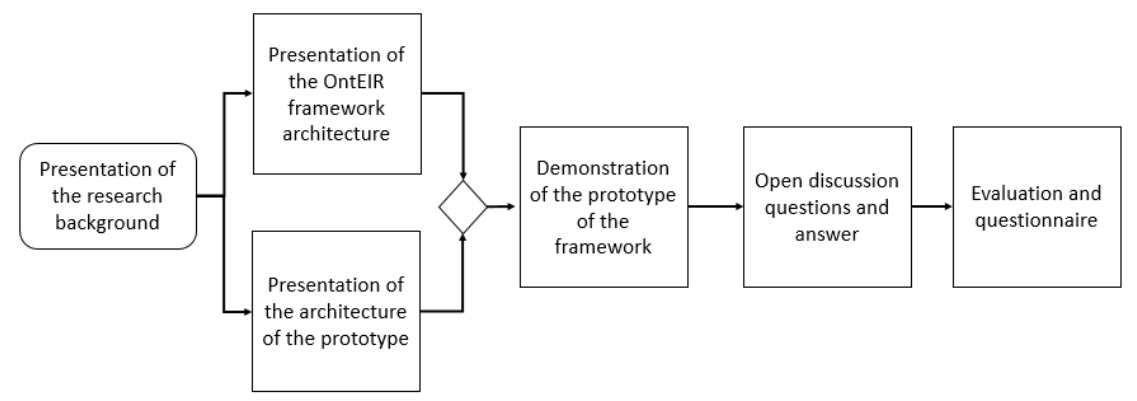
Figure 7. The Focus Group Evaluation Process.